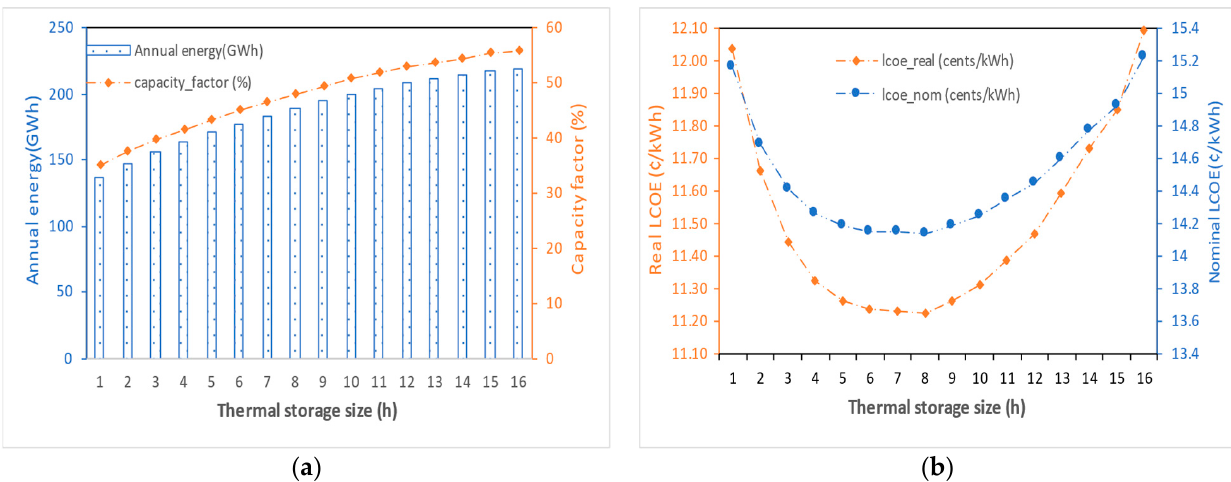
Figure 8. Influence of TES on ( a ) the annual energy produced and capacity factor and ( b ) LCOEs